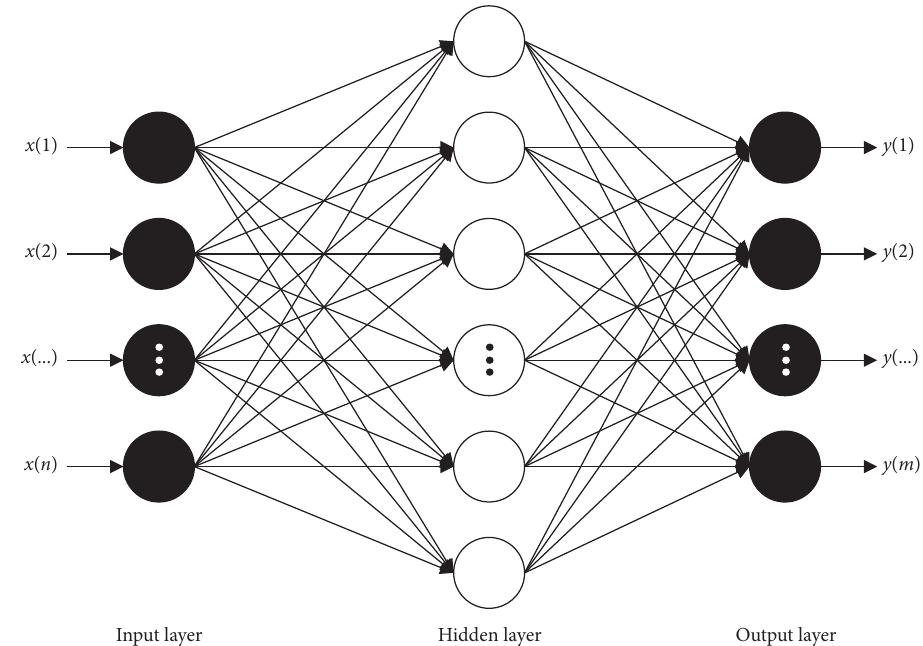
Figure 1: Single-hidden-layer neural network